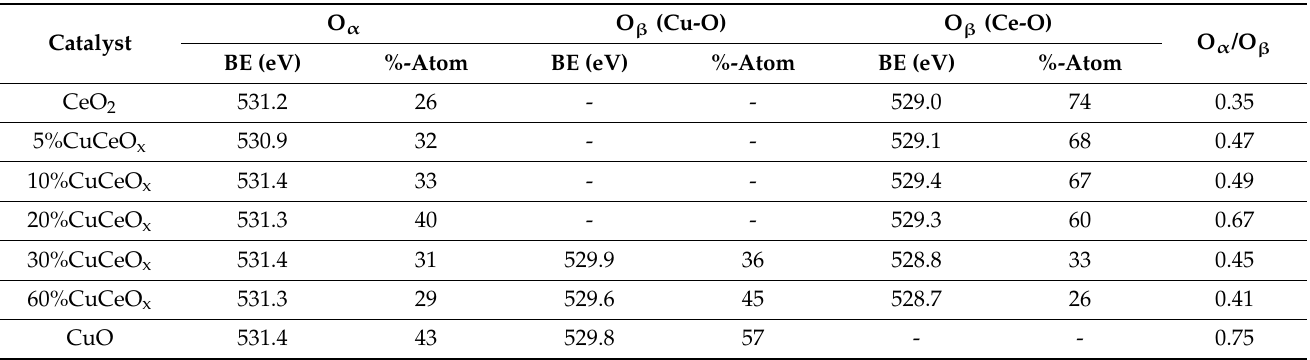
Table 4. Relative amounts of the surface-adsorbed oxygen (O α ) and lattice oxygen (O β ) species and their respective ratios, as derived from the deconvolution of the O 1 s core